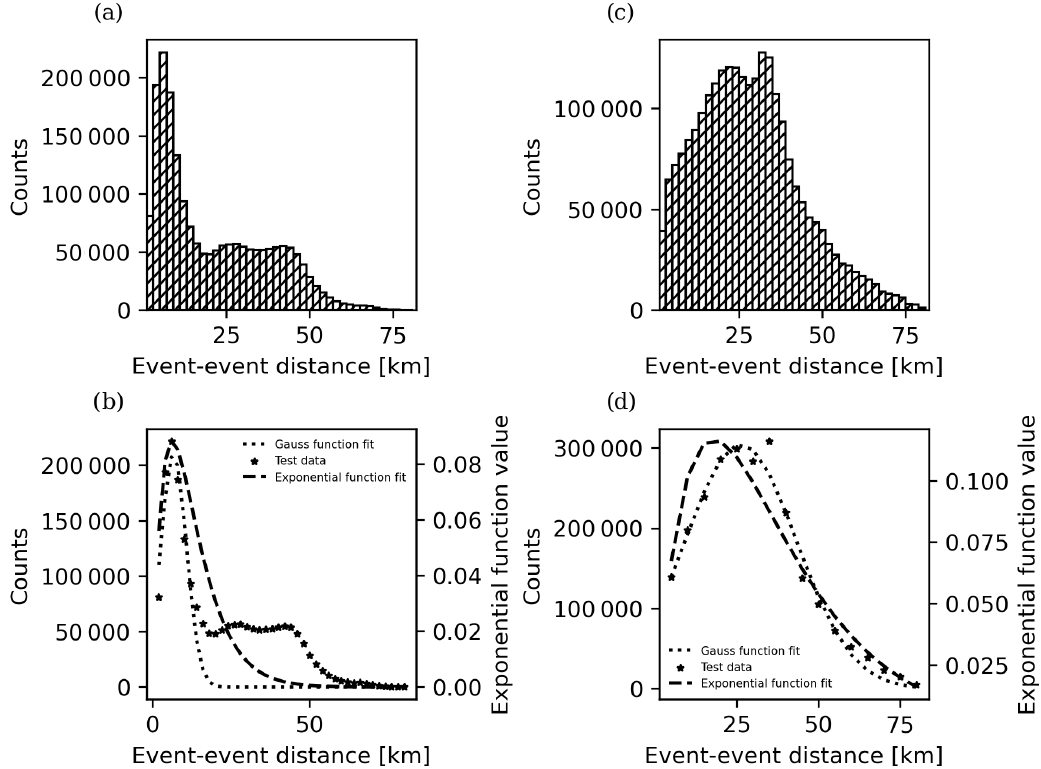
Figure 9. (a) Event-event distance distribution for events from 2000 to 2011. (b) Functions fit of the event-event distance distribution counts up to 14km distance for the data from 2000 to 2011. (c) Event-event distance distribution for events from 2011 to 2020. (d) Functions fit of the event-event distance distribution counts up to 80km distance for the data from 2011 to 2020. Table 2. Parameters obtained by fitting the Gaussian and exponential functions to the counts in the event-event distance distribution for the Lorca area catalog. The last column shows the R 2 of the